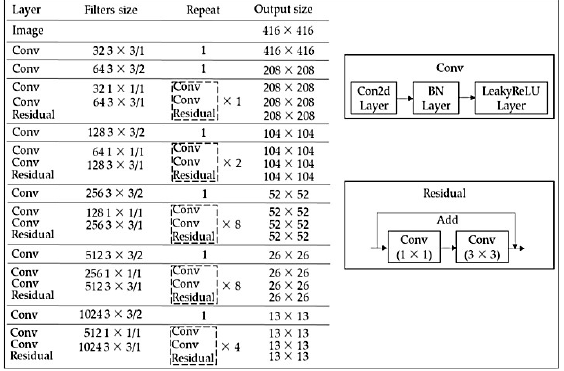
Figure 7. Structure of the Darknet53 convolutional